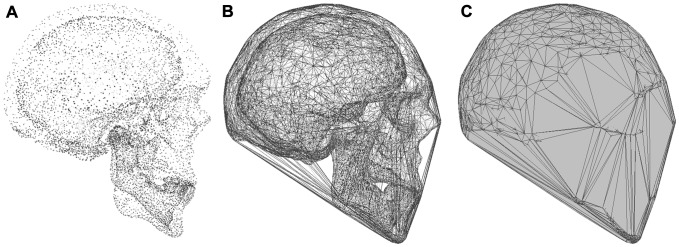
Convex hulling applied to a human skull.A, point cloud representing both the inner and outer surface contours of the skull; B, illustrates fit of the convex hull around the maximum extent of the skull; C, convex manifold (water-tight) polytope fitted by the hulling operation.